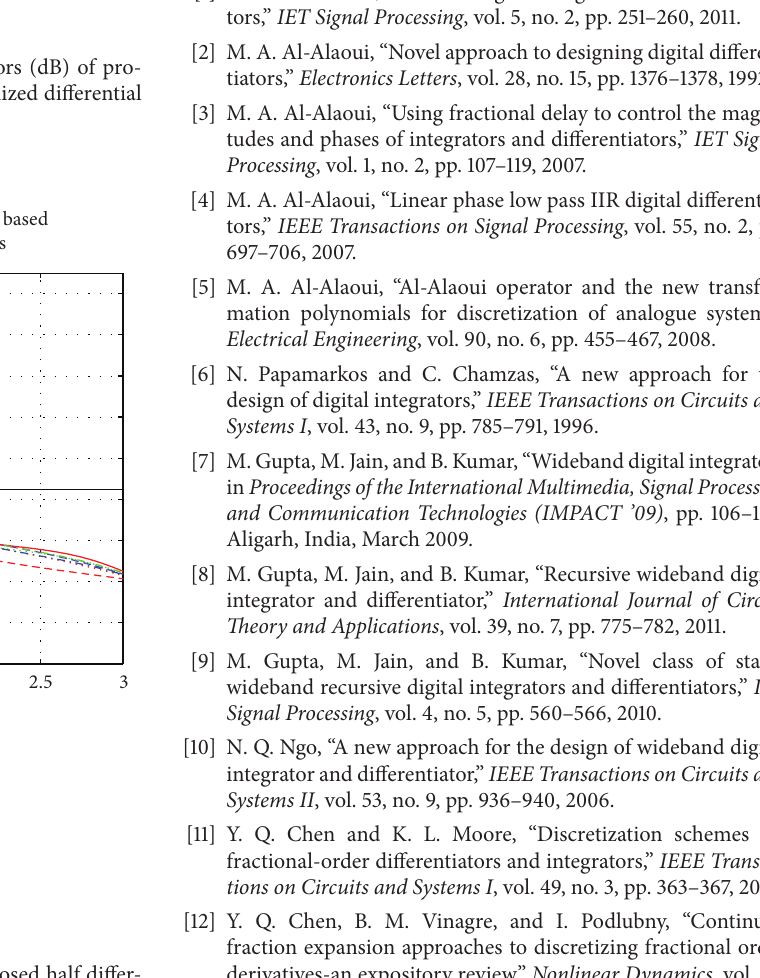
Figure 11: Comparison of phase responses of proposed half differ- entiators based on 3rd order optimized differential